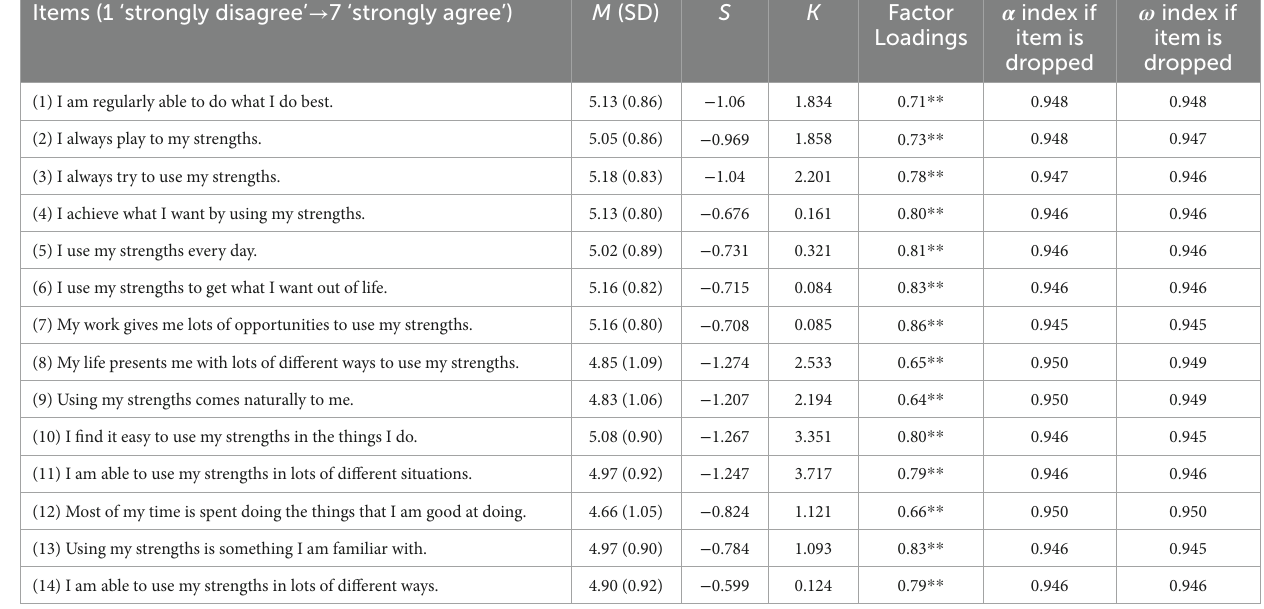
TABLE 2 Descriptive statistics and factor loadings of the strength use scale (Study 1). Items (1 ‘strongly disagree’ → 7 ‘strongly